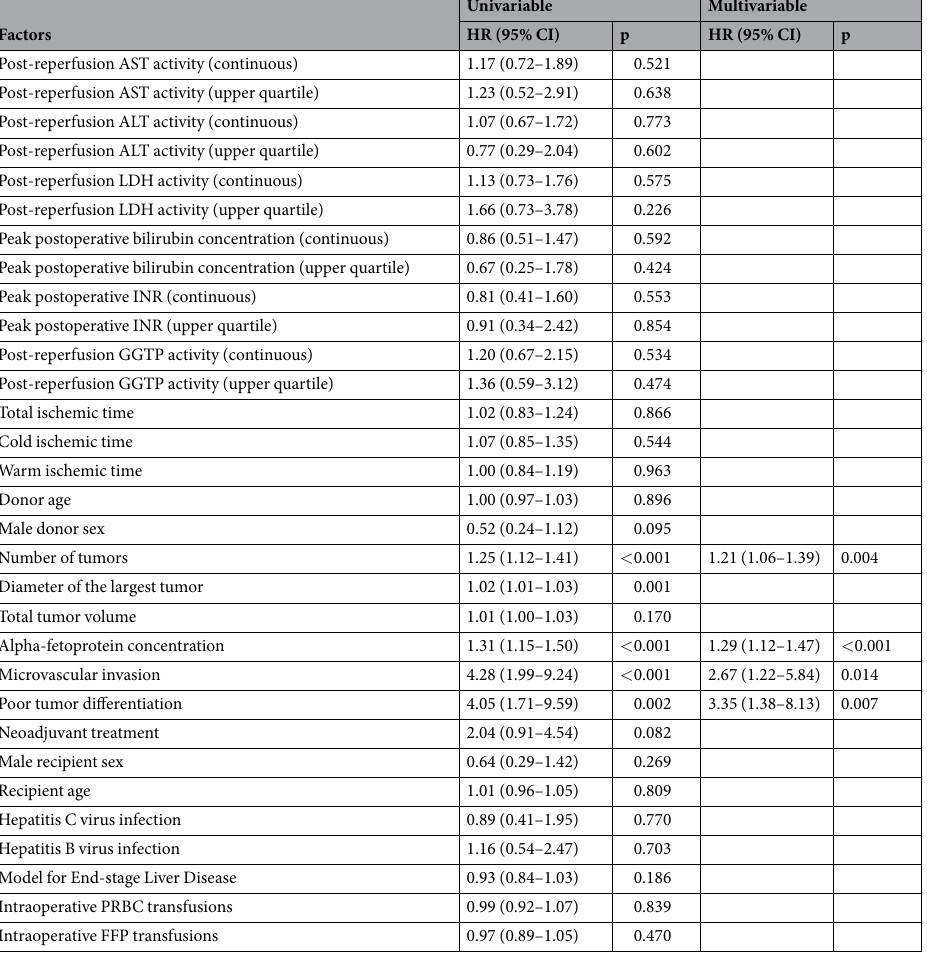
Table 3. Analyses of risk factors for hepatocellular carcinoma recurrence after deceased donor liver transplantation. Hazard ratios for continuous variables are given per: 1 log e (U/L) increase for AST, ALT, LDH, and GGTP activity; 1 increase for INR; 1 hour increase for total and cold ischemic times; 10 minute increase for warm ischemic time; 1 year increase for recipient and donor age; 1 increase for tumor number; 1 mm increase for diameter of the largest tumor; 10 cm 3 increase for total tumor volume; 1 log e (ng/ml) increase for alpha-fetoprotein concentration; 1 point increase for Model for End-stage Liver Disease; and 1 unit increase for transfusions. HR - hazard ratio; 95% CI – 95% confidence interval; AST – aspartate transaminase; ALT